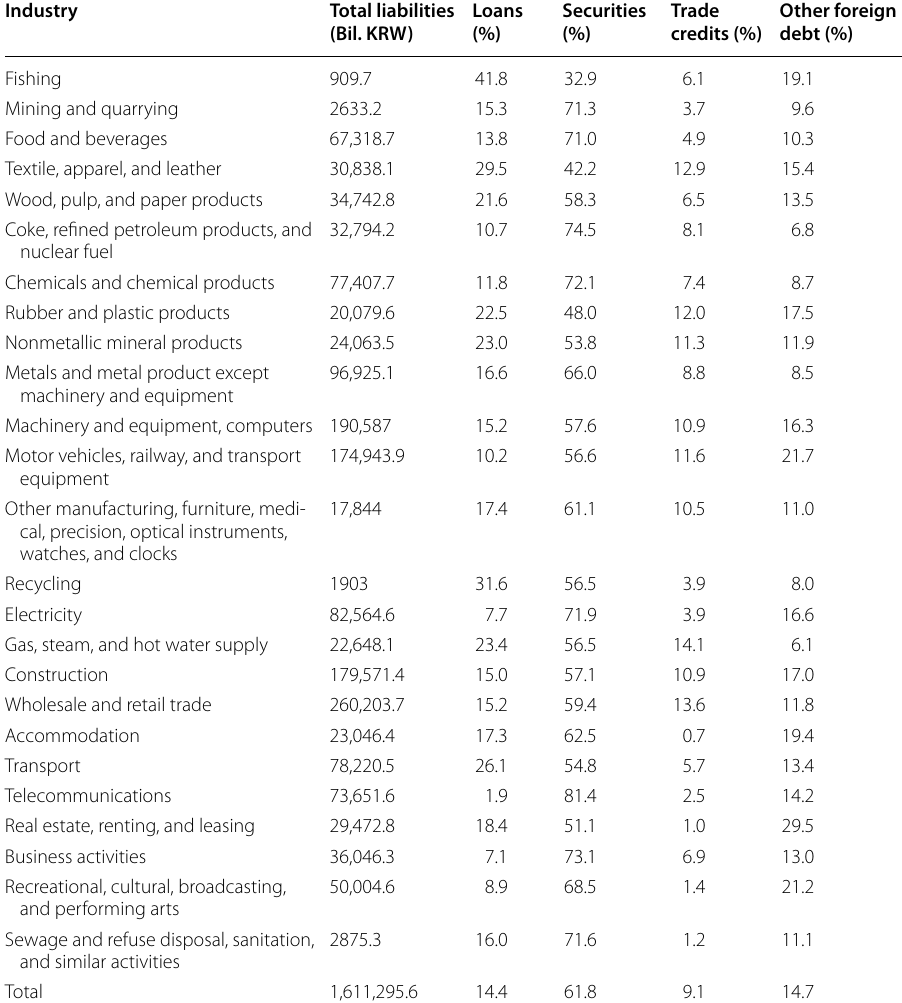
Table 5 Inter-industry liability portfolio in 2005 Industry Total liabilities (Bil.